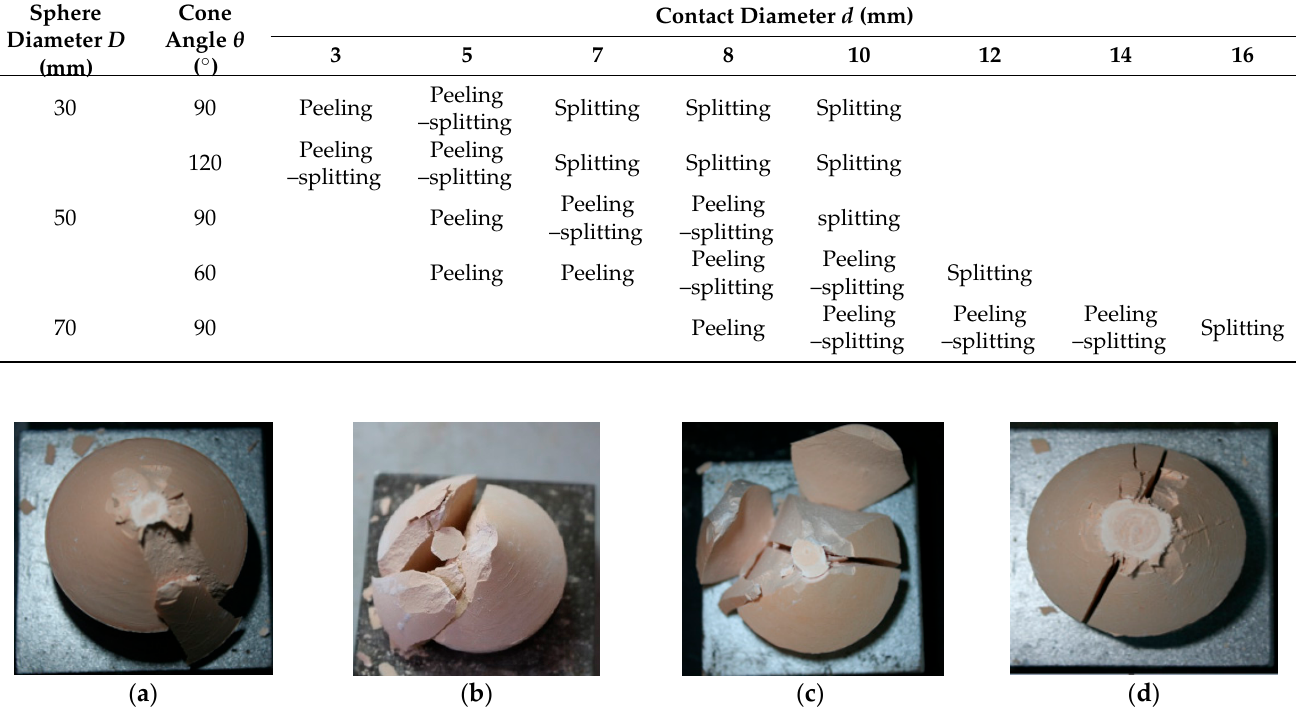
( c ) Figure 9. Breakage modes change with the increase in cone angle θ when the sphere diameter D is 50 mm and contact diameter is 7 mm: ( a ) θ = 60 ° ; ( b ) θ = 90 ° ; ( c ) θ =120 ° . ( a ) ( c ) Figure 10. Breakage modes change with the increase in sphere diameter D when cone angle θ is 90 ° and contact diameter is 8 mm: ( a ) D = 30 mm; ( b ) D = 50 mm; ( c ) D = 70 mm. 3.2. Force–Displacement Curves The force–displacement curves are significantly different among the three breakage modes. Figure 11a shows the typical peeling force–displacement curves. The normal force increases linearly with displacement, during which the local crushing happens and then fluctuates in a certain range due to a few small fragments peeled off. The larger re- duction in the normal force is attributed to the bigger fragment. For particle peeling– splitting, the normal force experiences a more visible plummet after a linearly increasing and floating process, mainly caused by more severe local crushing and peeling (see Fig- ure 11b). In this stage, the particle crushes into two pieces. After that, the normal force increases gently because the broken pieces could continue to support the load. The force– displacement curve of the particle splitting (see Figure 11c) is similar to that of spherical particle splitting [Error! Reference source not found.]. The normal force increases linear- ly, accompanied by the occurrence of local crushing, and then drops steeply to almost zero since the particle breaks into pieces.